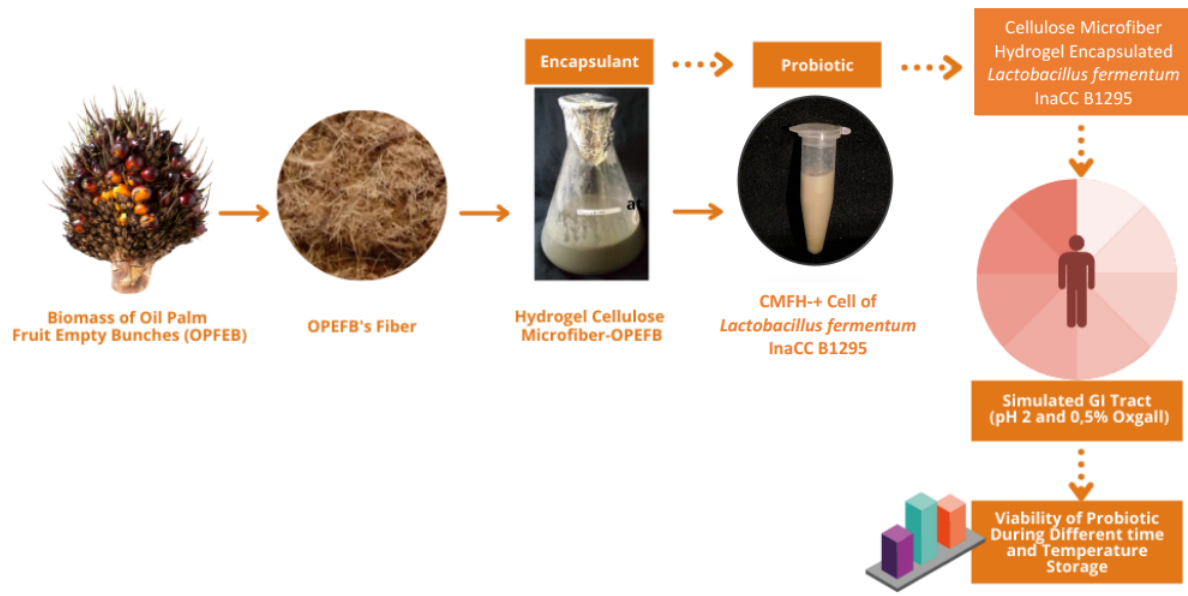
Figure 1. Flowchart of the research methodology.